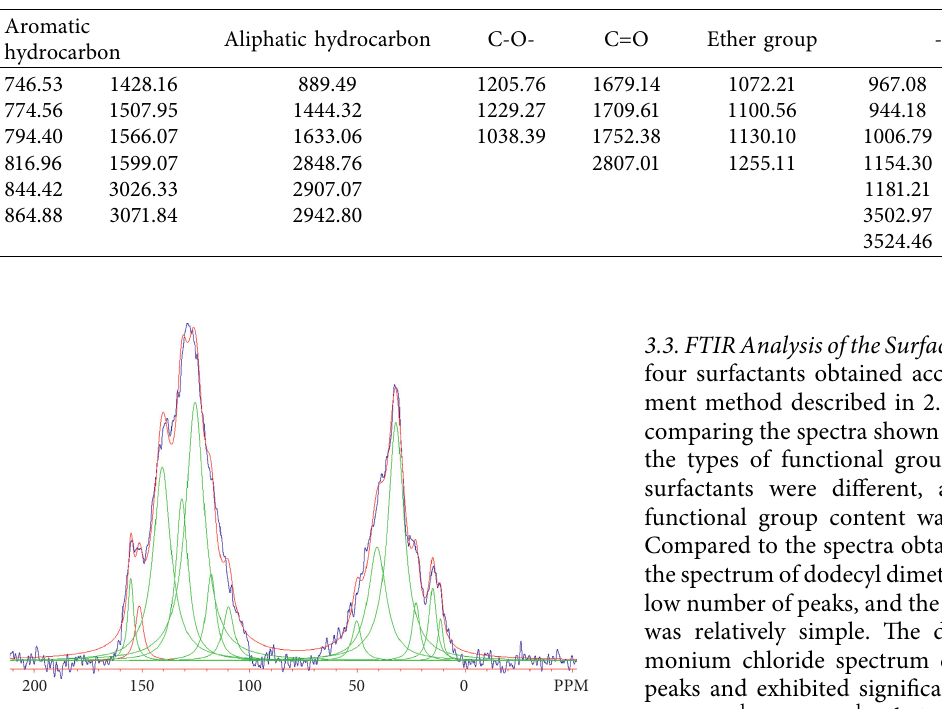
Figure 6: 13 C-NMR spectrum of bituminous coal